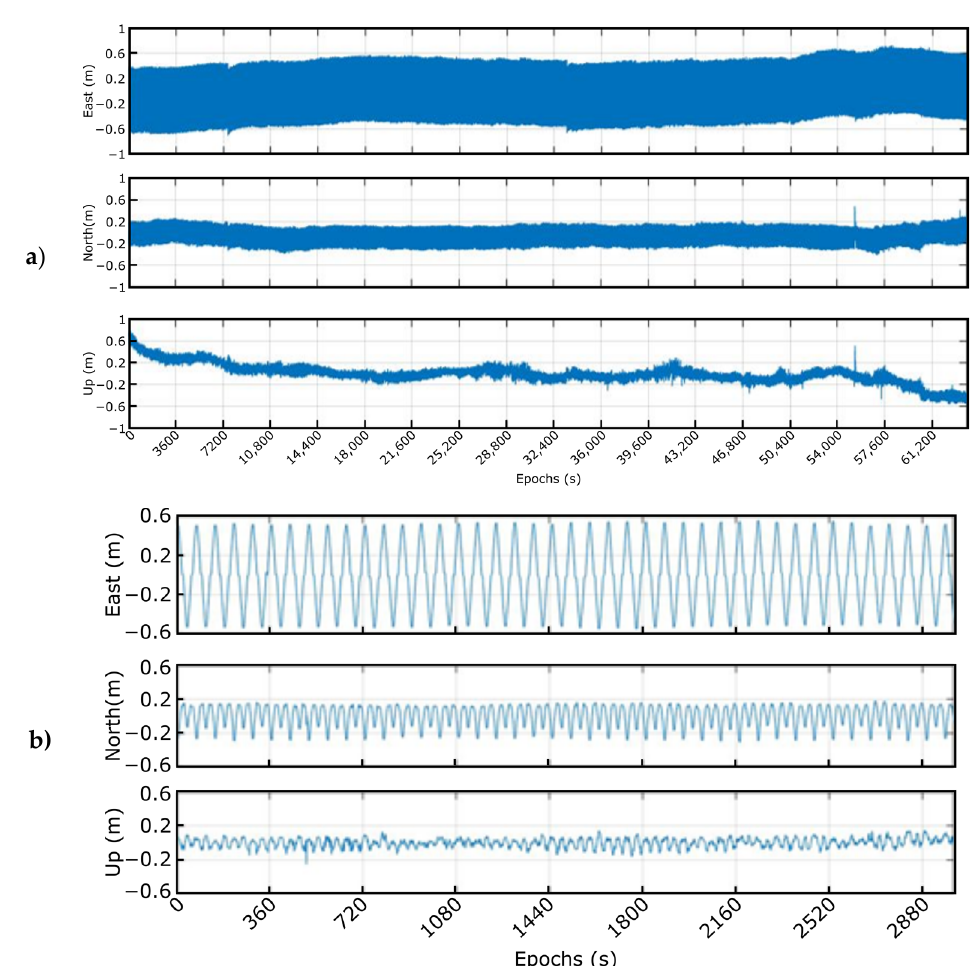
Figure 15. Solution rotating around A and B simultaneously: ( a ) 18 h, ( b ) 1 h.